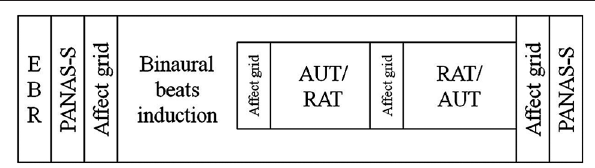
FIGURE 1 | Diagram of the task order in every session . Participants always completed the tasks in this order, regardless of beat frequency. Whether a participant completed the alternate uses task (AUT) before the remote associations task (RAT) (or vice versa) was randomized across